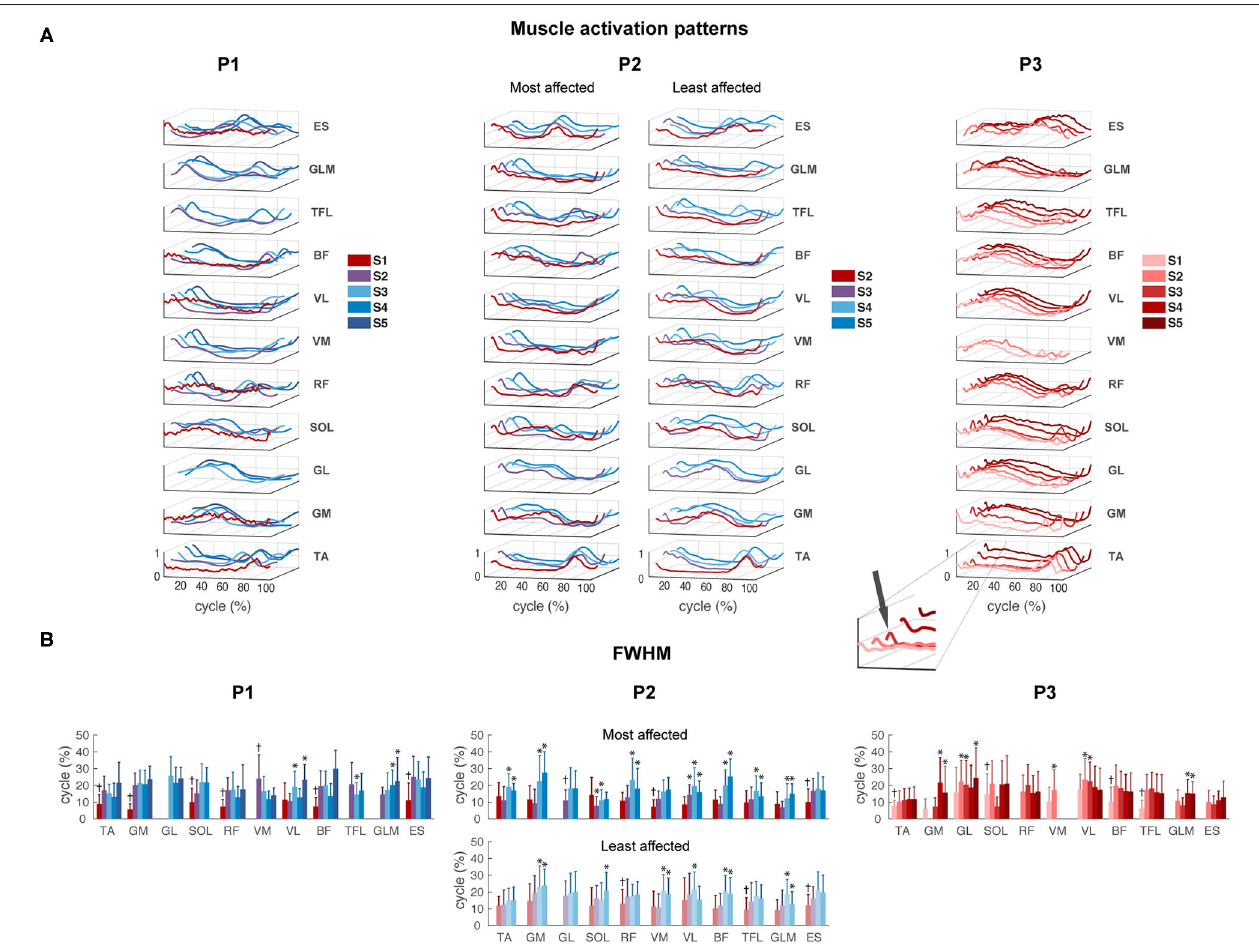
FIGURE 4 | EMG activity. (A) Muscle activation patterns averaged across strides per session for P1–P3, for the most and least affected legs in P2. The peak around foot strike is emphasized in the zoom-in view of the TA muscle of P3. (B) Full-width of the half maximum (FWHM) per muscle per session in P1–P3. TA, tibialis anterior; GM, gastrocnemius medialis; GL, gastrocnemius lateralis; SOL, soleus; RF, rectus femoris; VM, vastus medialis; VL, vastus lateralis; BF, biceps femoris; TFL, tensor fascia latae; GLM, gluteus maximus; ES, erector spinae at L2 level. *Significant difference compared to the first recorded session of this muscle. † All sessions are significantly different from the first recorded